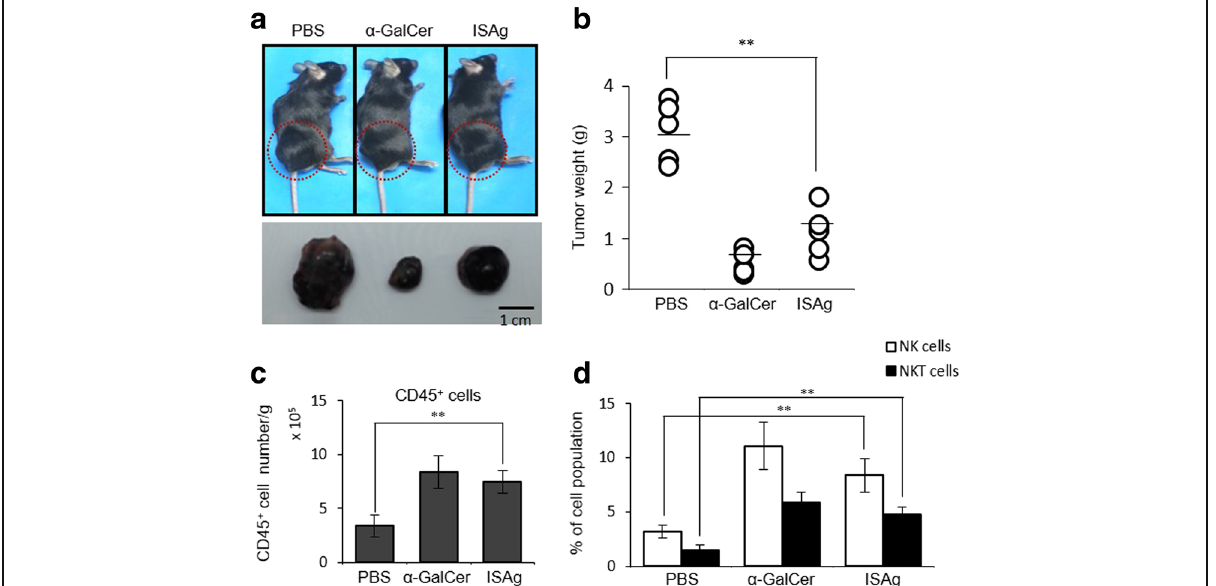
Fig. 7 Anti-tumor effects by ISAg were associated with boosted cytotoxicity of NK receptor-expressing innate immune cells. Yet40 B6 mice were treated via the oral route with ISAg (4 mg/injection) or PBS three times per week beginning 1 week after tumor injection and ending at 3 weeks. As a positive control, mice were injected (i.p.) two times per week beginning at 1 week after tumor injection until 3 weeks with α -GalCer (2 μ g) dissolved in PBS. The mice were euthanized at day 21 after B16 tumor cell injection. The spleen and tumor tissues were excised from each mouse. a Representative photographs of a mouse from each treatment, 21 days after tumor injection (top row). Photographs of the tumors from each of the mice in the top row (bottom row). b The weights of the tumors from individual mice are presented mean ± standard deviation values ( n = 5 per group; Student ’ s t-test; ** P < 0.01). c , d On day 21 after injection, mononuclear cells were isolated from the tumors of mice in the indicated treatment groups using a Percoll gradient. c The absolute numbers of CD45 + cells per gram of tumor tissue were assessed using flow cytometry. d The frequencies of the NK and NKT cells among the CD45 + cells from the tumors were evaluated using